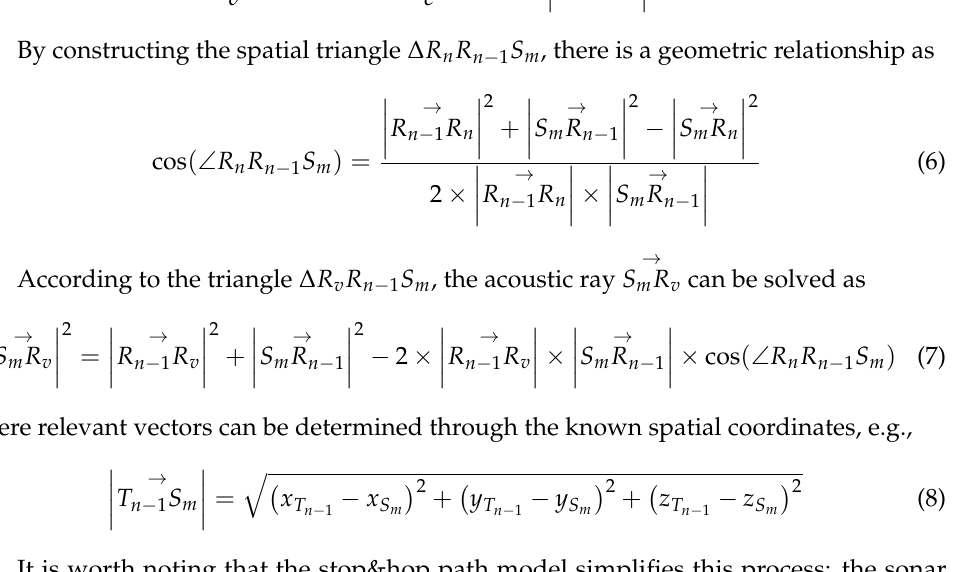
( b ) Figure 7. Echo parameters in the receiving beam footprint (Figure 6c): ( a ) incident angle; ( b ) DOA.